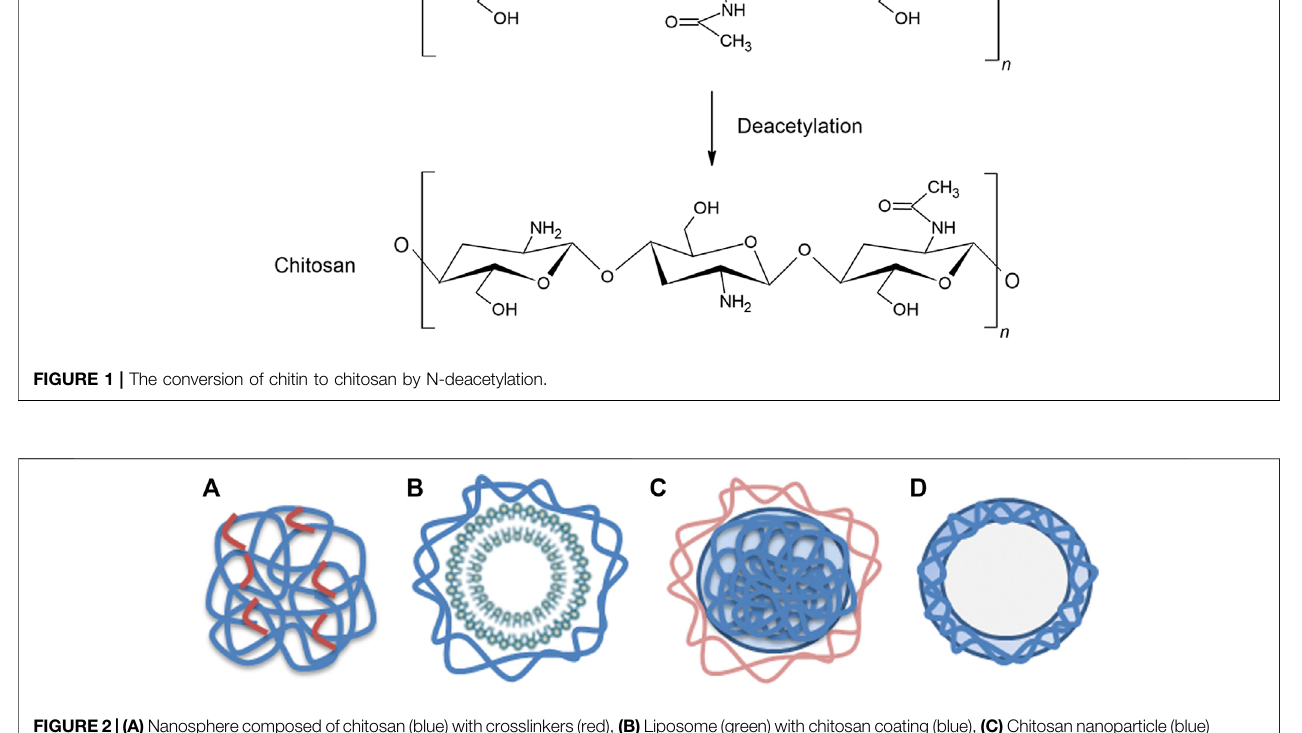
Frontiers in Pharmacology |